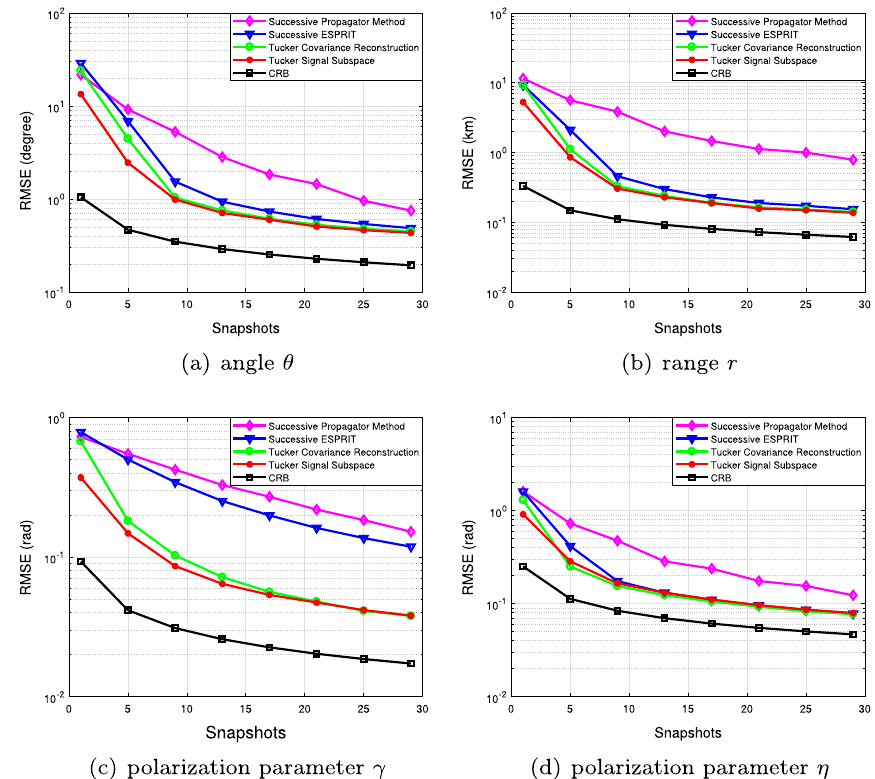
Fig. 7 RMSE versus snapshot for range, angle and polarization estimation using different methods. M = 6 , N = 6 , P = 3 , SNR 0 dB and 100 independent trials. (θ , r ) = ( 40 ◦ ,4km ) , ( − 30 ◦ ,2km ) , ( 10 ◦ ,5km ) and = (γ , η) = (π/ 10, π/ 5 )(π/ 5,3 π/ 5 )(π/ 4,2 π/ 5